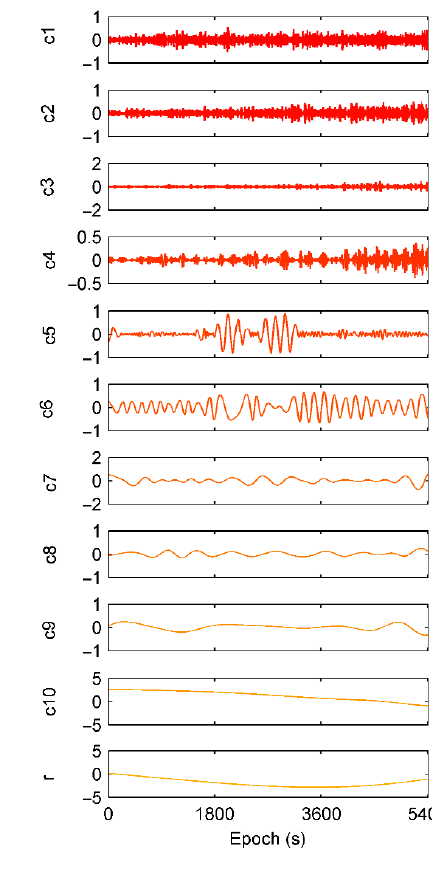
( b ) Figure 10. Time-frequency spectrums of IMFs for CMC . ( a ) C09 and ( b ) G19. Figure 11. Signal reflection and multipath effects.